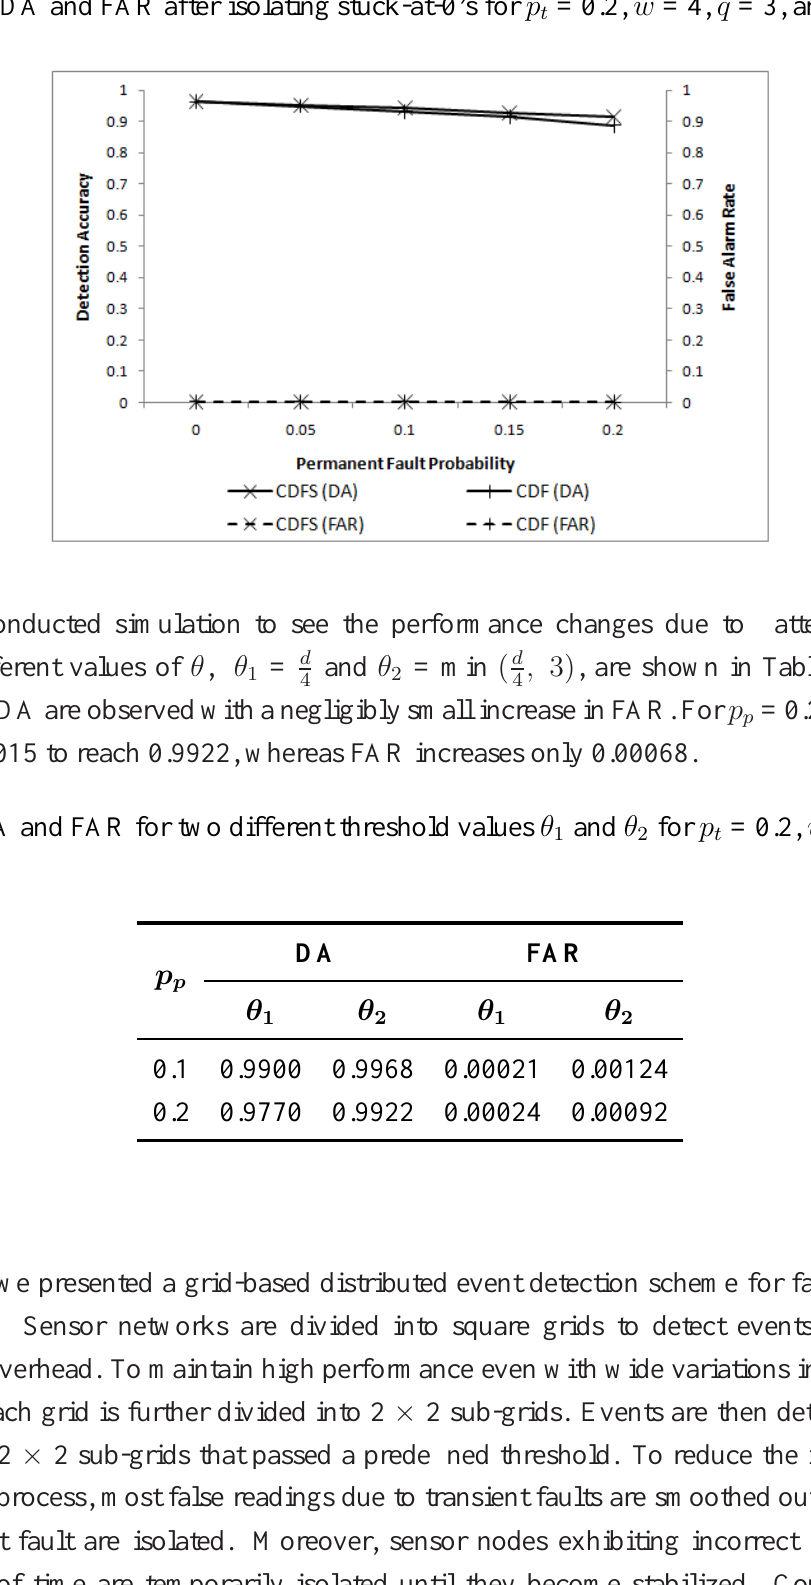
Figure 7. DA and FAR after isolating stuck-at-0’s for p